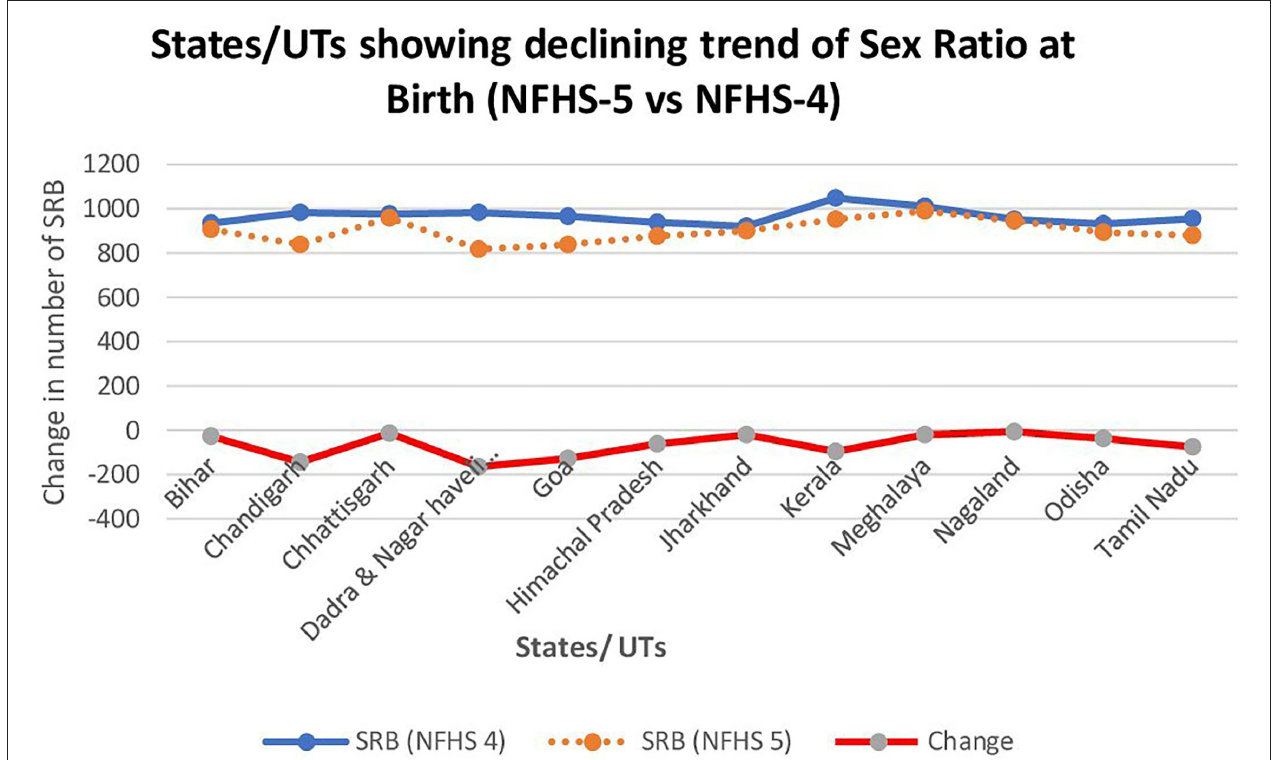
FIGURE 1 | States/UTs having declined in Sex Ratio at Birth as per NFHS 5 (2019–2021) vs. NFHS 4